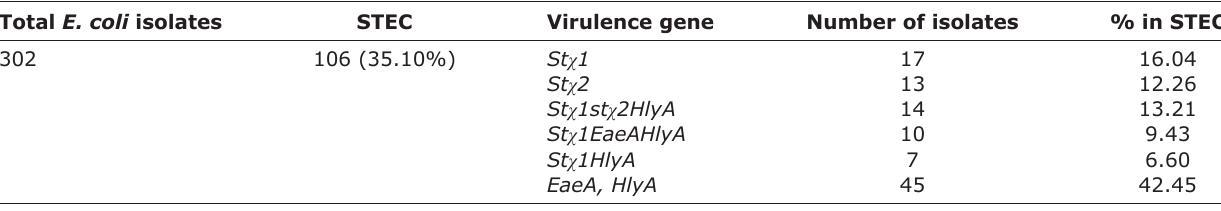
Table-3: Distribution of virulence genes among STEC isolates in diarrheic buffalo calves. Total E. coli isolates